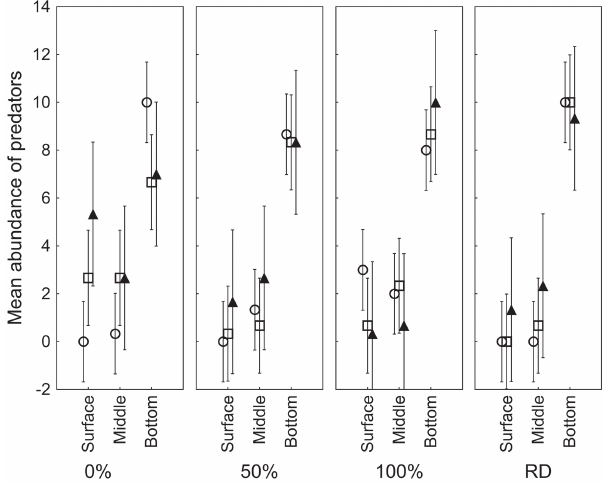
Fig. 7 . Use of microhabitat (surface, middle and bottom) by the Nile Tilapia (mean ± SD) in the tanks with Pseudoplatystoma corruscans (white circles), Salminus brasiliensis (white squares) and Brycon orbignyanus (black triangles), for 0%, 50%, 100% and RD treatments. The three-way ANOVA for these data suggested significant (P = 0.045) interaction between species, structural complexity and use of microhabitat. The juveniles used the surface and bottom layers more frequently.